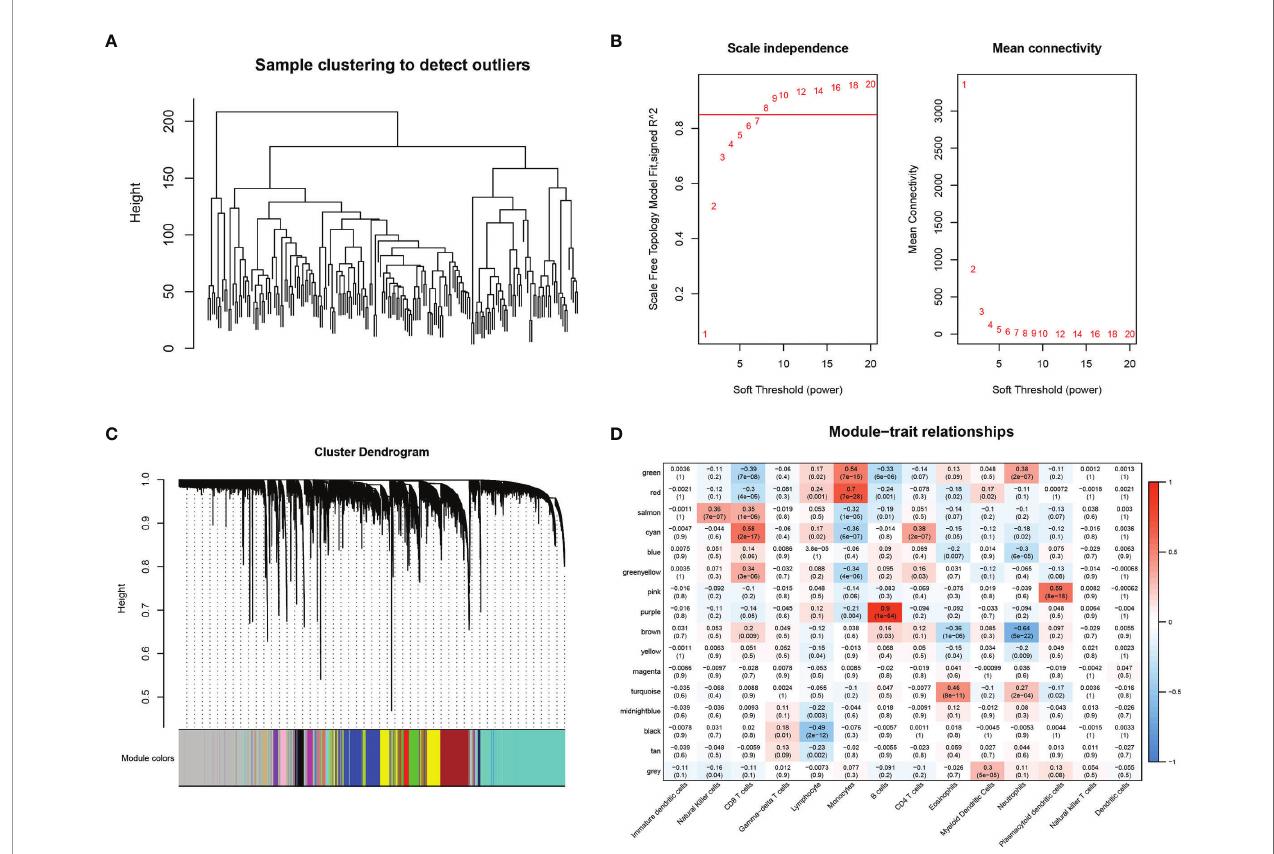
FIGURE 1 | WGCNA-based co-expression analysis of CD8 + T cell-associated genes. (A) Sample clustering analysis. (B) Analysis of network topology for various soft-thresholding powers. (C) Gene dendrogram and module colors. (D) Correlation results between the 16 modules and each clinical